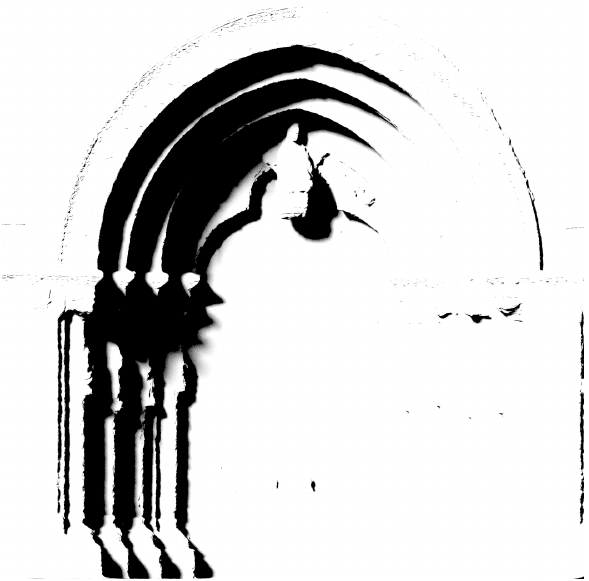
Figure 8: Projected shadows layer, showing areas that will